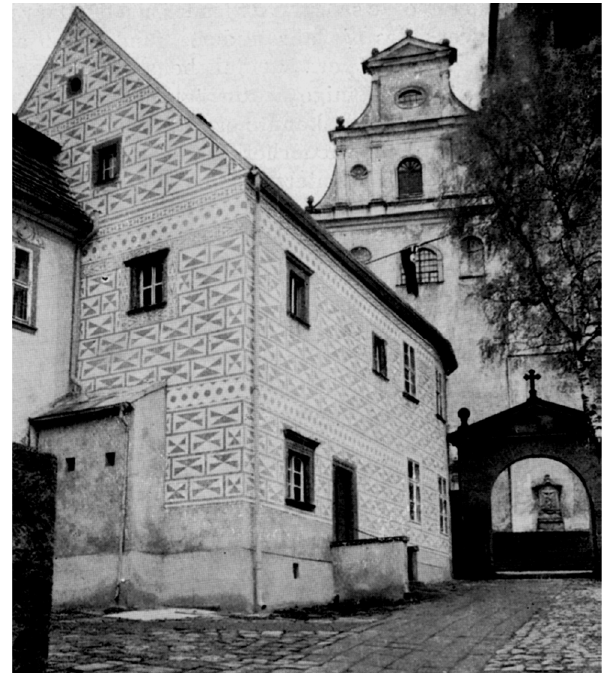
Figure 39. Sgraffito covering the in 1934 façades parish school in Chełmsko Śląskie (now the parish building). Source: Schlesische Heimatpfleg (1935, p. 175).